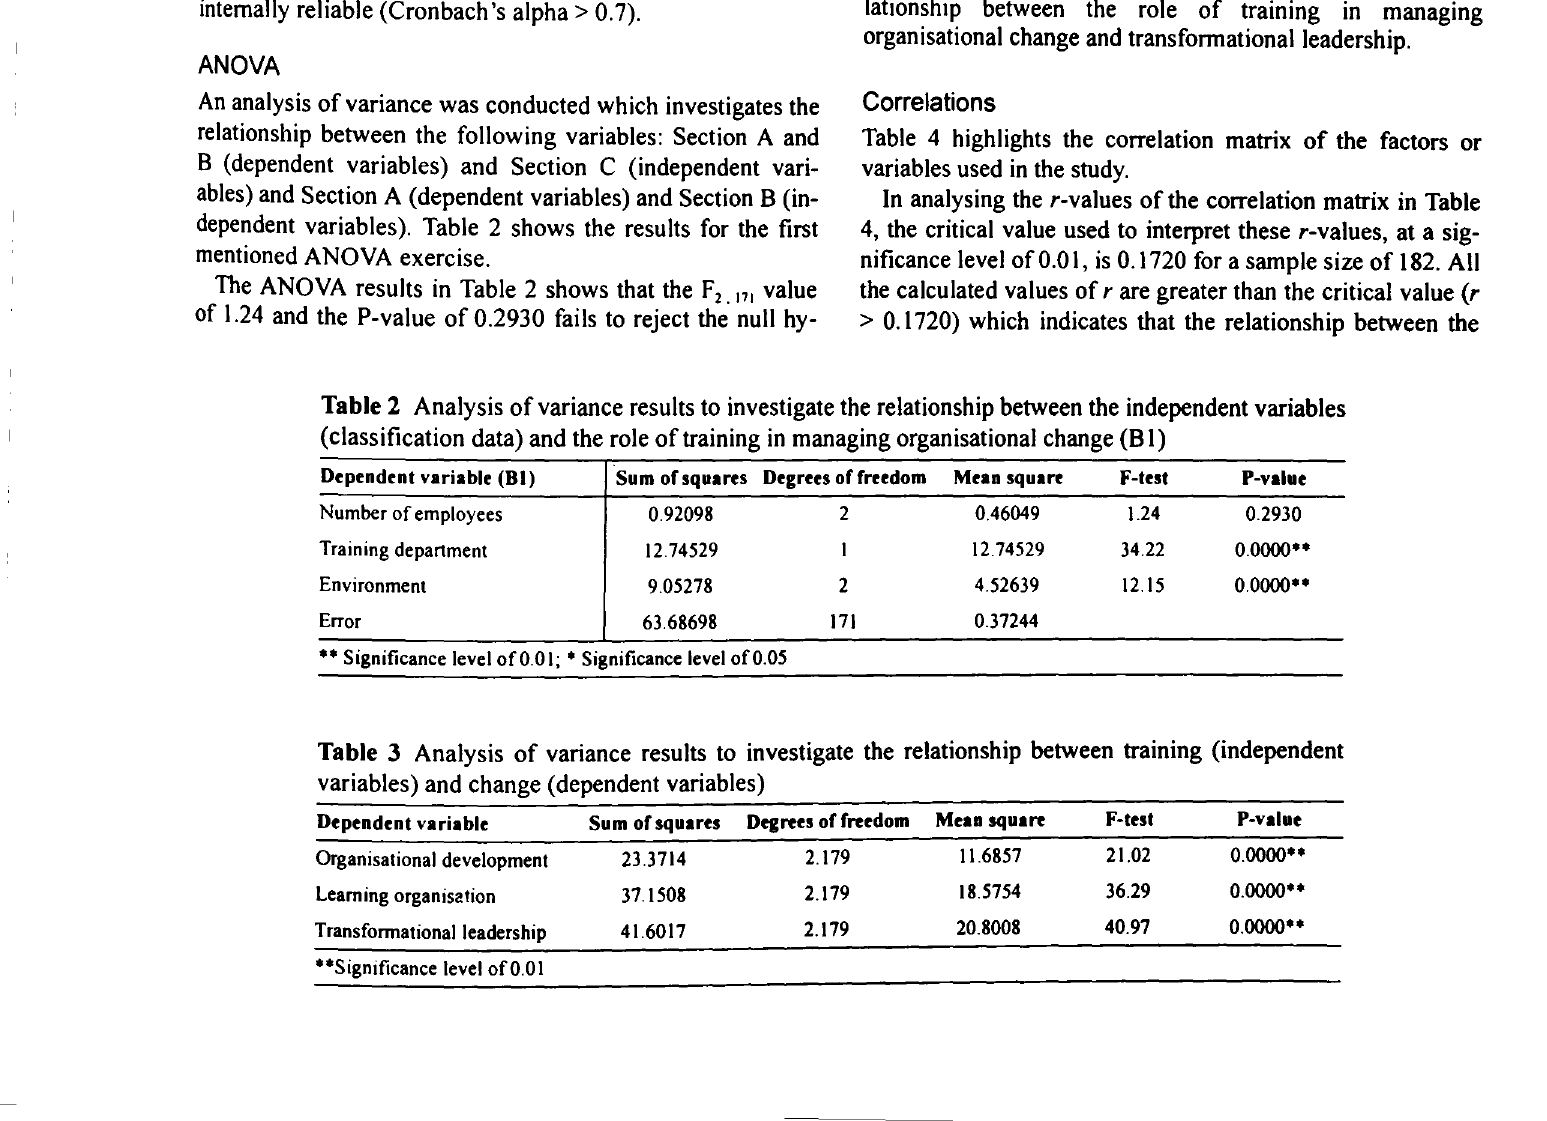
transfonnational leadership (0.95) and Section B (training